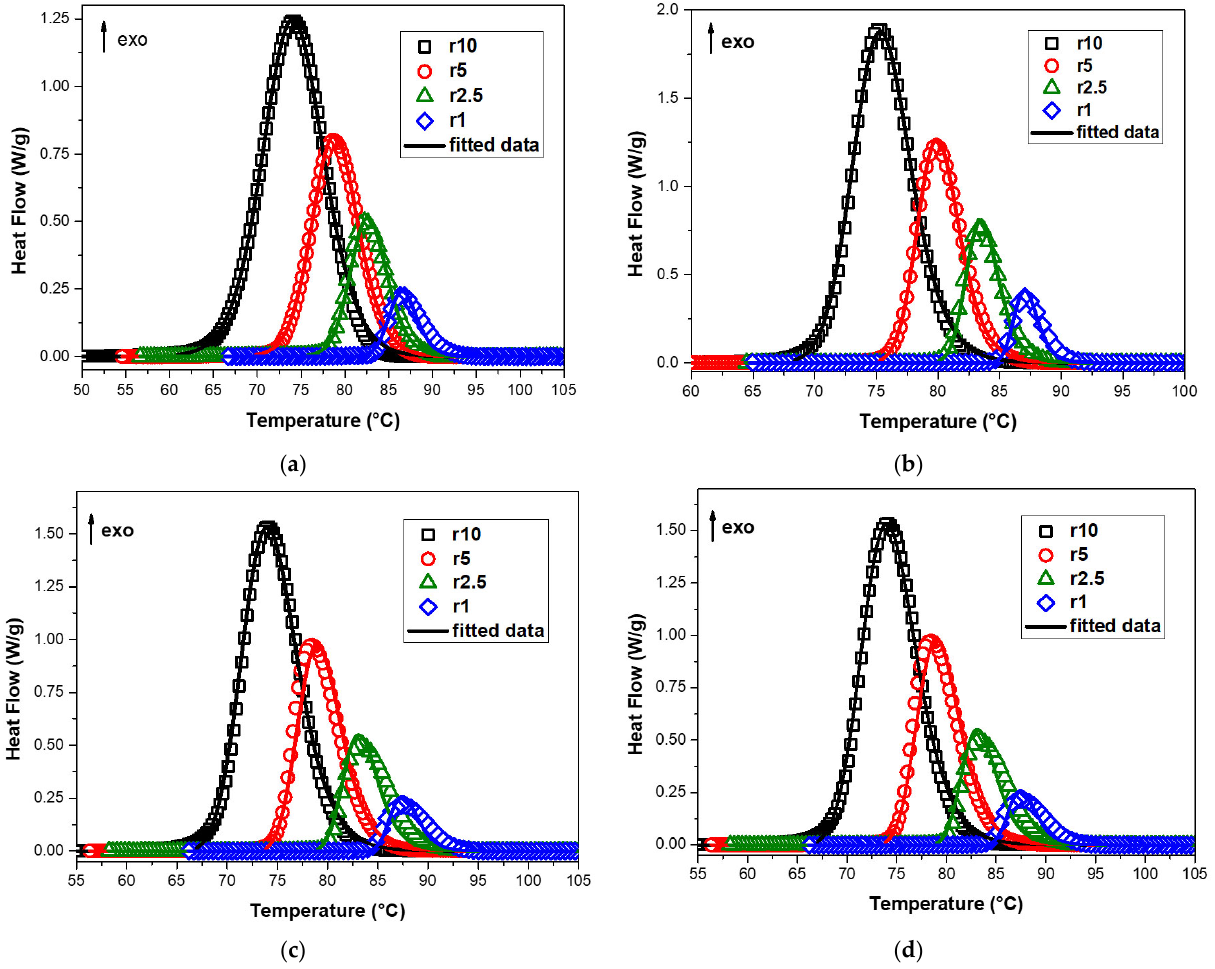
Figure 10. Heat flow curves of ( a ) neat PBSu, ( b ) PBSu/1% biochar, ( c ) PBSu/2.5% biochar, and ( d ) PBSu/5% biochar composites versus temperature and the corresponding fitting of multivariate nonlinear regression of the Šest á k–Berggren model with Hoffman–Lauritzen theory. Table 5. Parameters of the Šest á k–Berggren model with Hoffman–Lauritzen theory for the crystalliza- tion curves from the melt of neat PBSu and PBSu/biochar